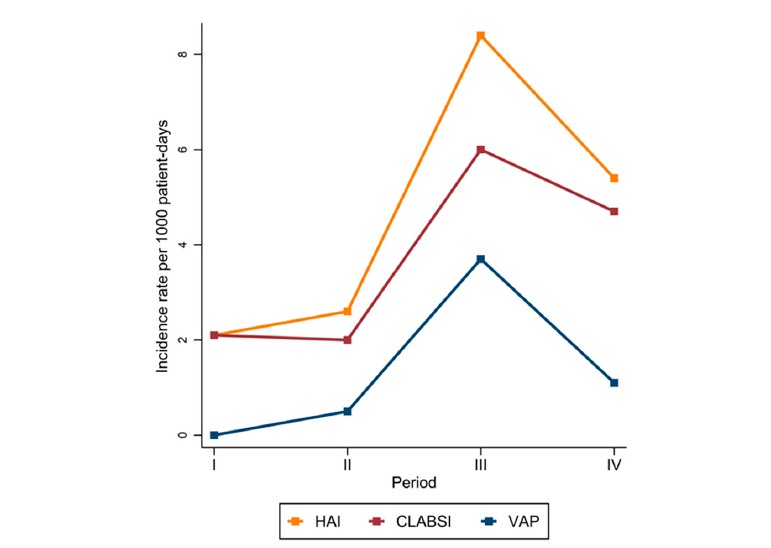
Figure 1. Incidence rate of first healthcare-associated infection (HAI) occurring in patients admitted to the neonatal intensive care unit of Umberto I teaching hospital of Rome between March 2018 and February 2022 by study period.